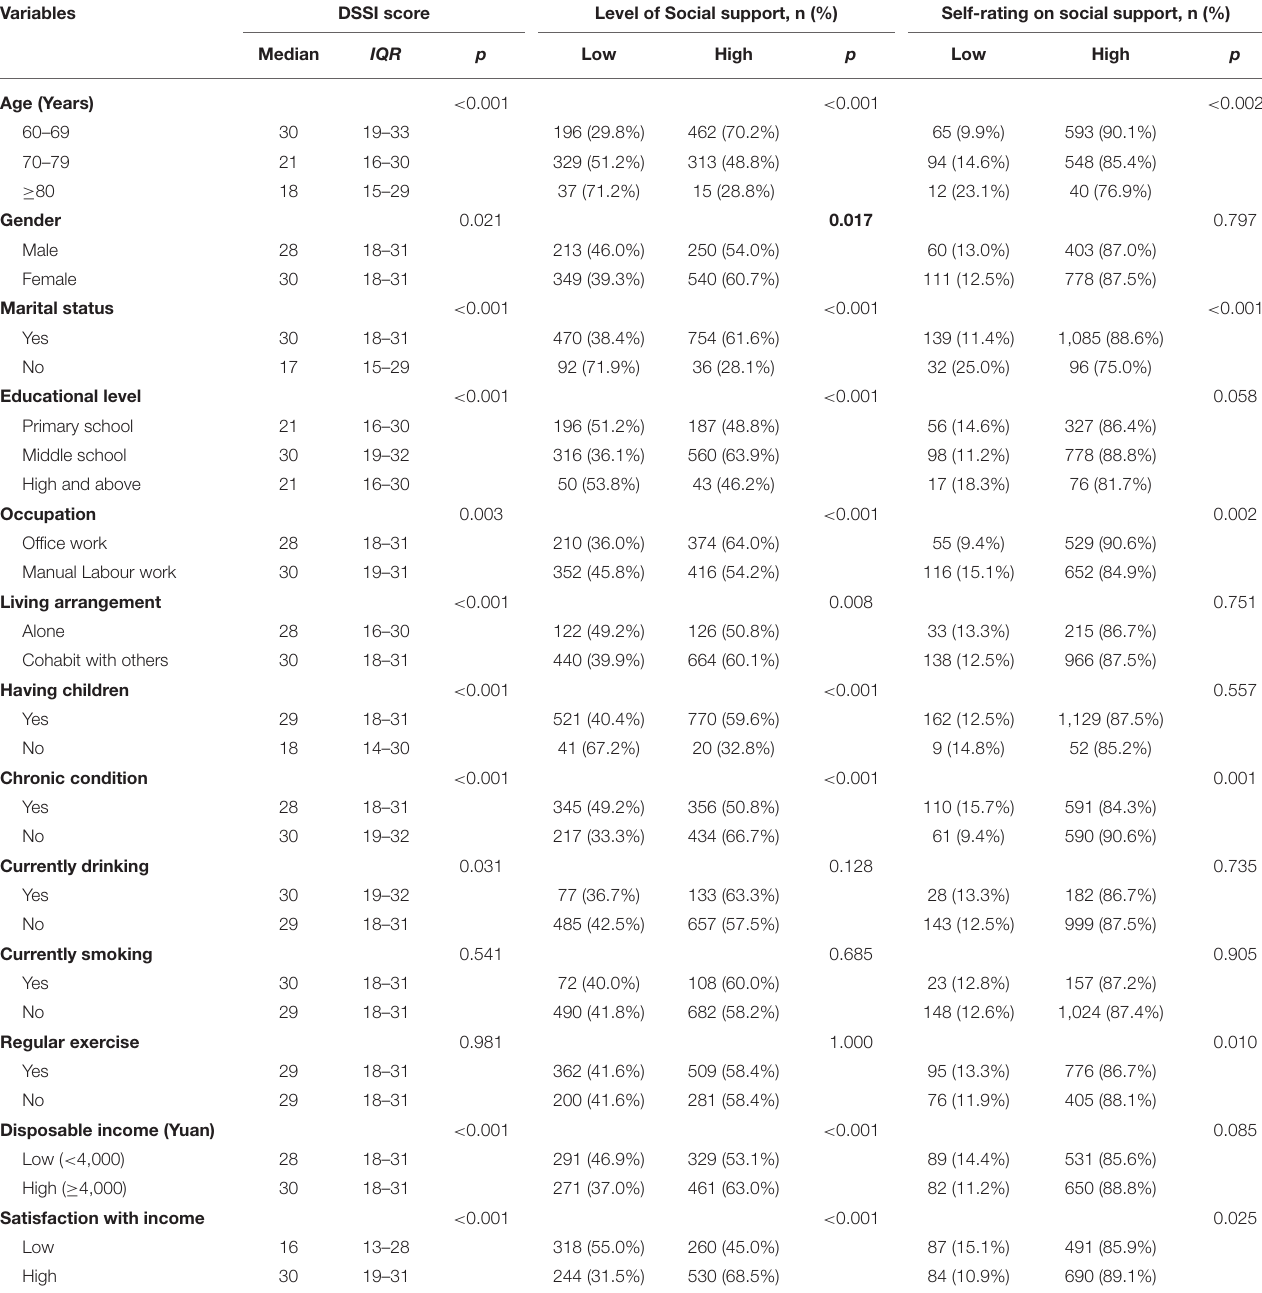
TABLE 3 | Sociodemographic factors associated with social